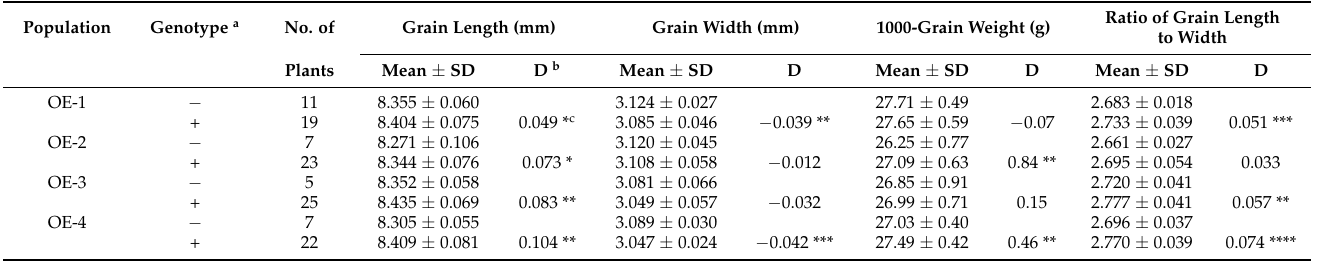
Table 2. Phenotypic performance of OsPUB3 driven by an Actin 1